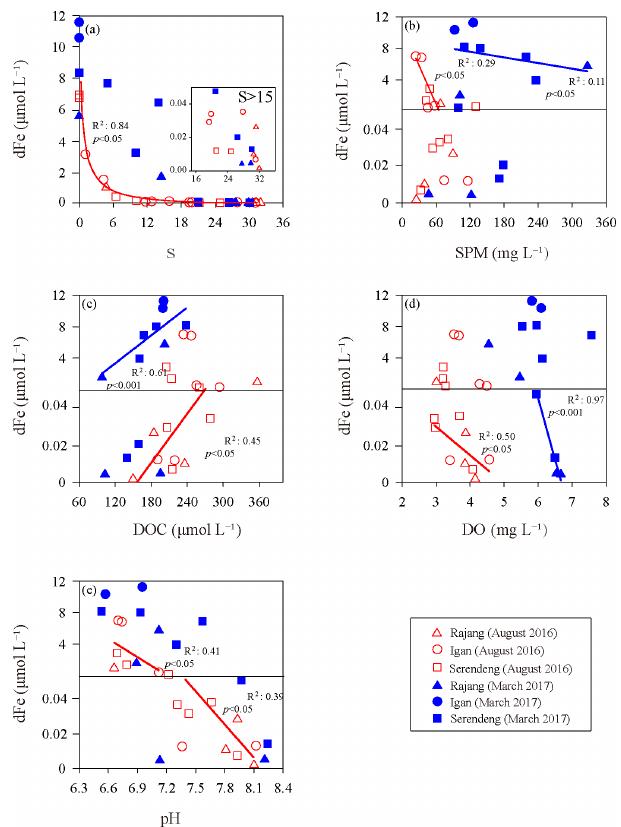
Figure 3. Correlation of the dissolved iron (dFe) with the salinity ( S ) (a) , suspended particulate matter (SPM) (b) , dissolved organic carbon (DOC) (c) , dissolved oxygen (DO) (d) and pH (e) in the Ra- jang estuary. The solid lines were the linear regressions between dFe and other factors, and the colors of the lines were coincident with the data points in different salinity range. Serendeng is the stations in tributary Paloh and Lassa, and Rajang is the stations in tributary Belawai and Rajang.